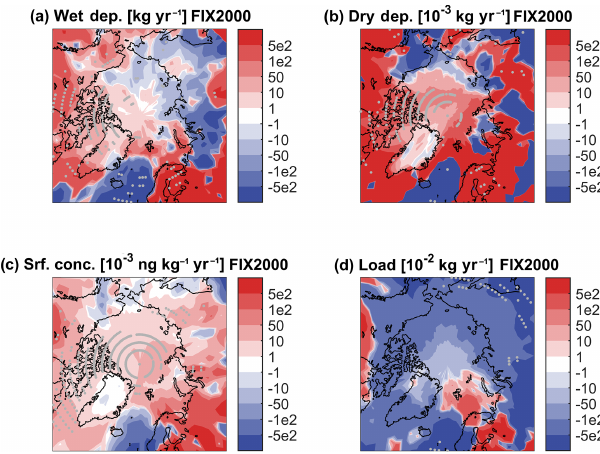
Figure 2. Winter (DJF) trends (1980–2005) of BC wet deposi- tion (a) , dry deposition (b) , surface concentration (d) and total load (d) for the ECHAM5–HAMMOZ REF simulation. Grey dots represent the grid points with trend significant at 5% level.